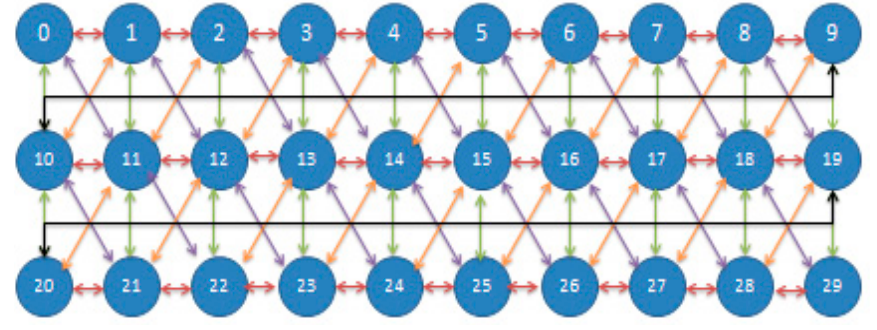
Figure 7. 30-Nodes Simulation Setup.